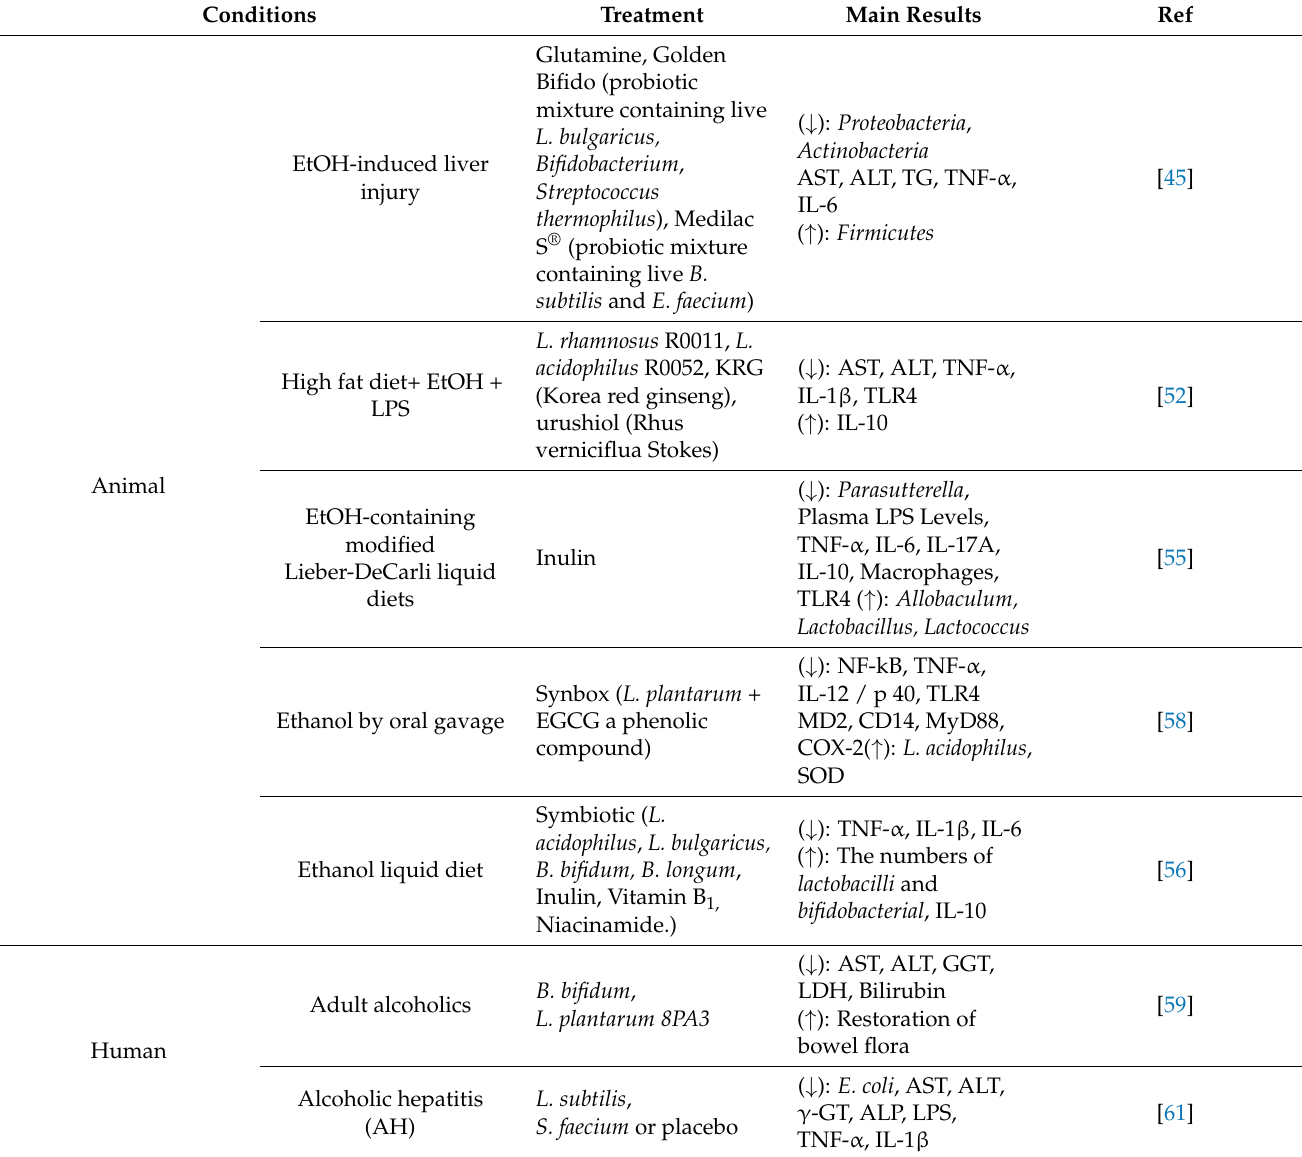
Table 2. Animal and human studies using diet in